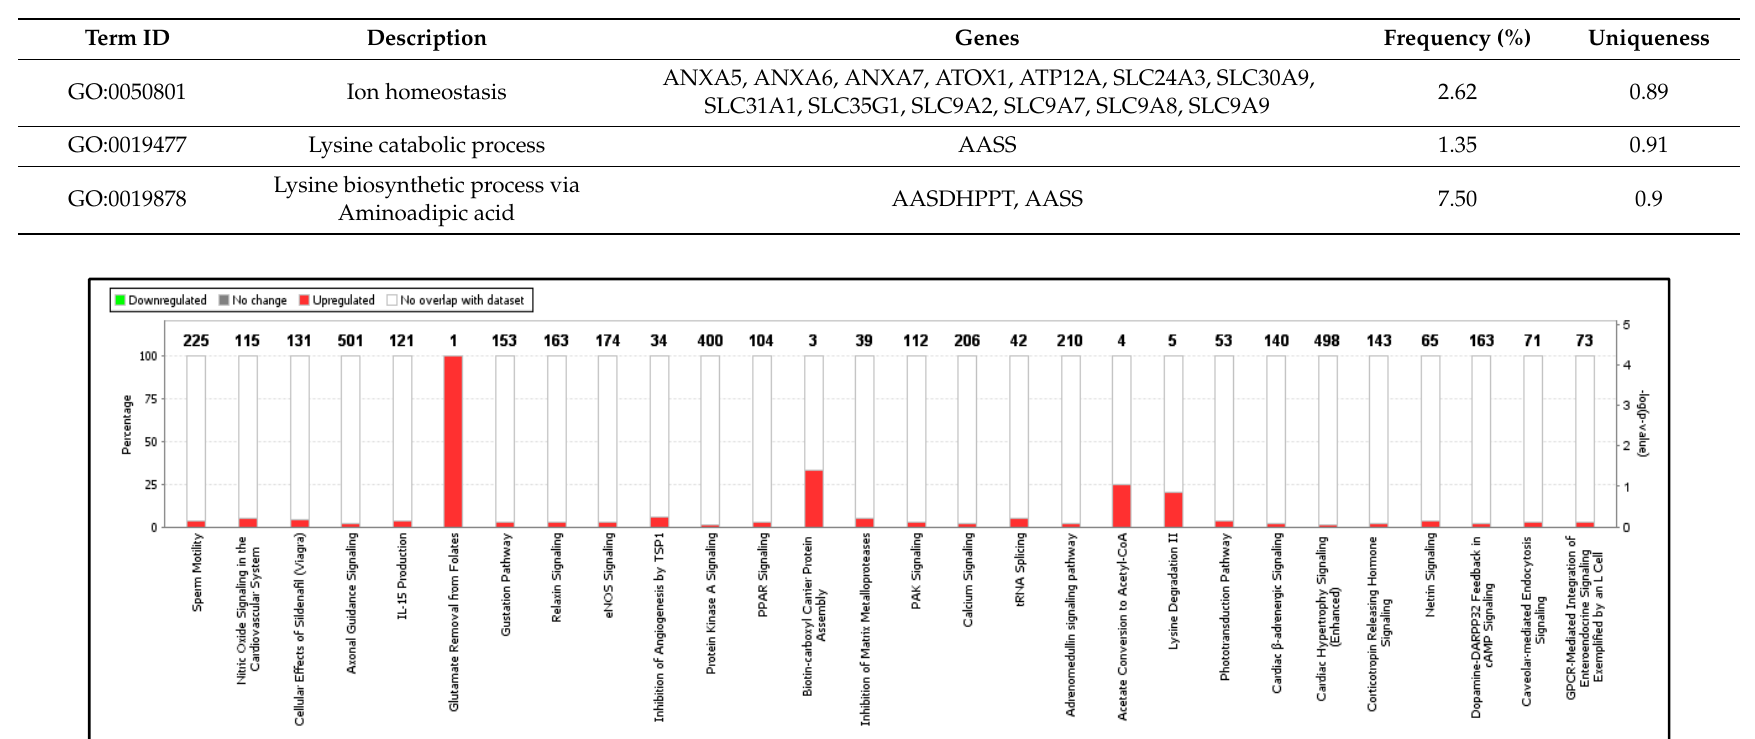
Figure 3. Gene ontology enrichment analysis of differentially expressed transcription factors in the lysine-deficient vs. lysine-adequate treatment groups of broiler chickens. X -axis indicates various significantly enriched pathways and number of differentially expressed transcriptional factors; Y -axis indicates the percentage of differentially expressed genes. The bars indicate upregulation and downregulation. Table 4. IPA summary of liver transcriptomes in samples from broiler chickens fed diets containing high and low lysine concentrations.